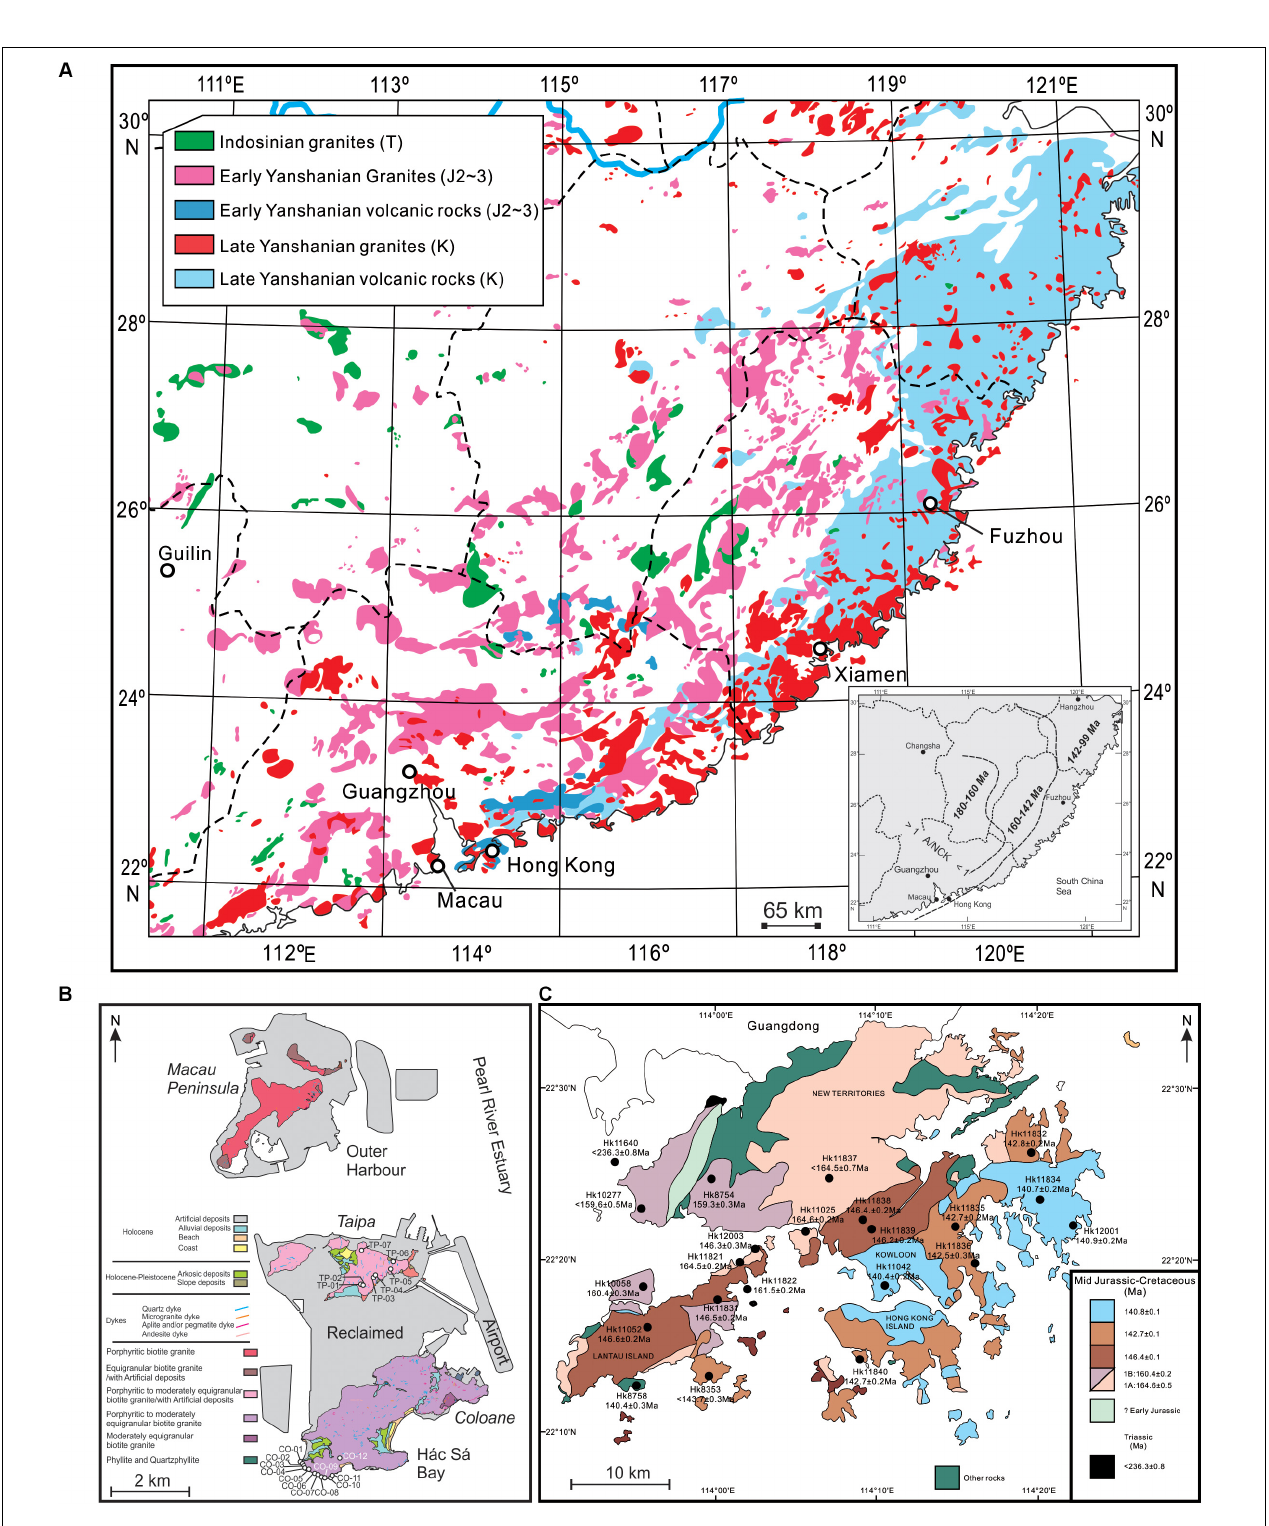
FIGURE 1 | (A) Regional geological map of the South China Block showing the spatial-temporal migration of Mesozoic magmatism from the interior to the coast. Inset map is of the age and compositional trend of Mesozoic volcanic and plutonic rocks of SE China. The alumina saturation index (A/NCK = Al/Na + Ca + K) of Mesozoic volcanic and plutonic rocks increases from NW to SE whereas the age decreases (Zhou et al., 2006). (B) Geological map of Macau Special Administrative Region showing the sample locations of this study (modified from Quelhas et al., 2020). (C) Geological map of Hong Kong Special Administrative Region showing locations of samples dated using high precision zircon U-Pb methods (modified from Davis et al., 1997).